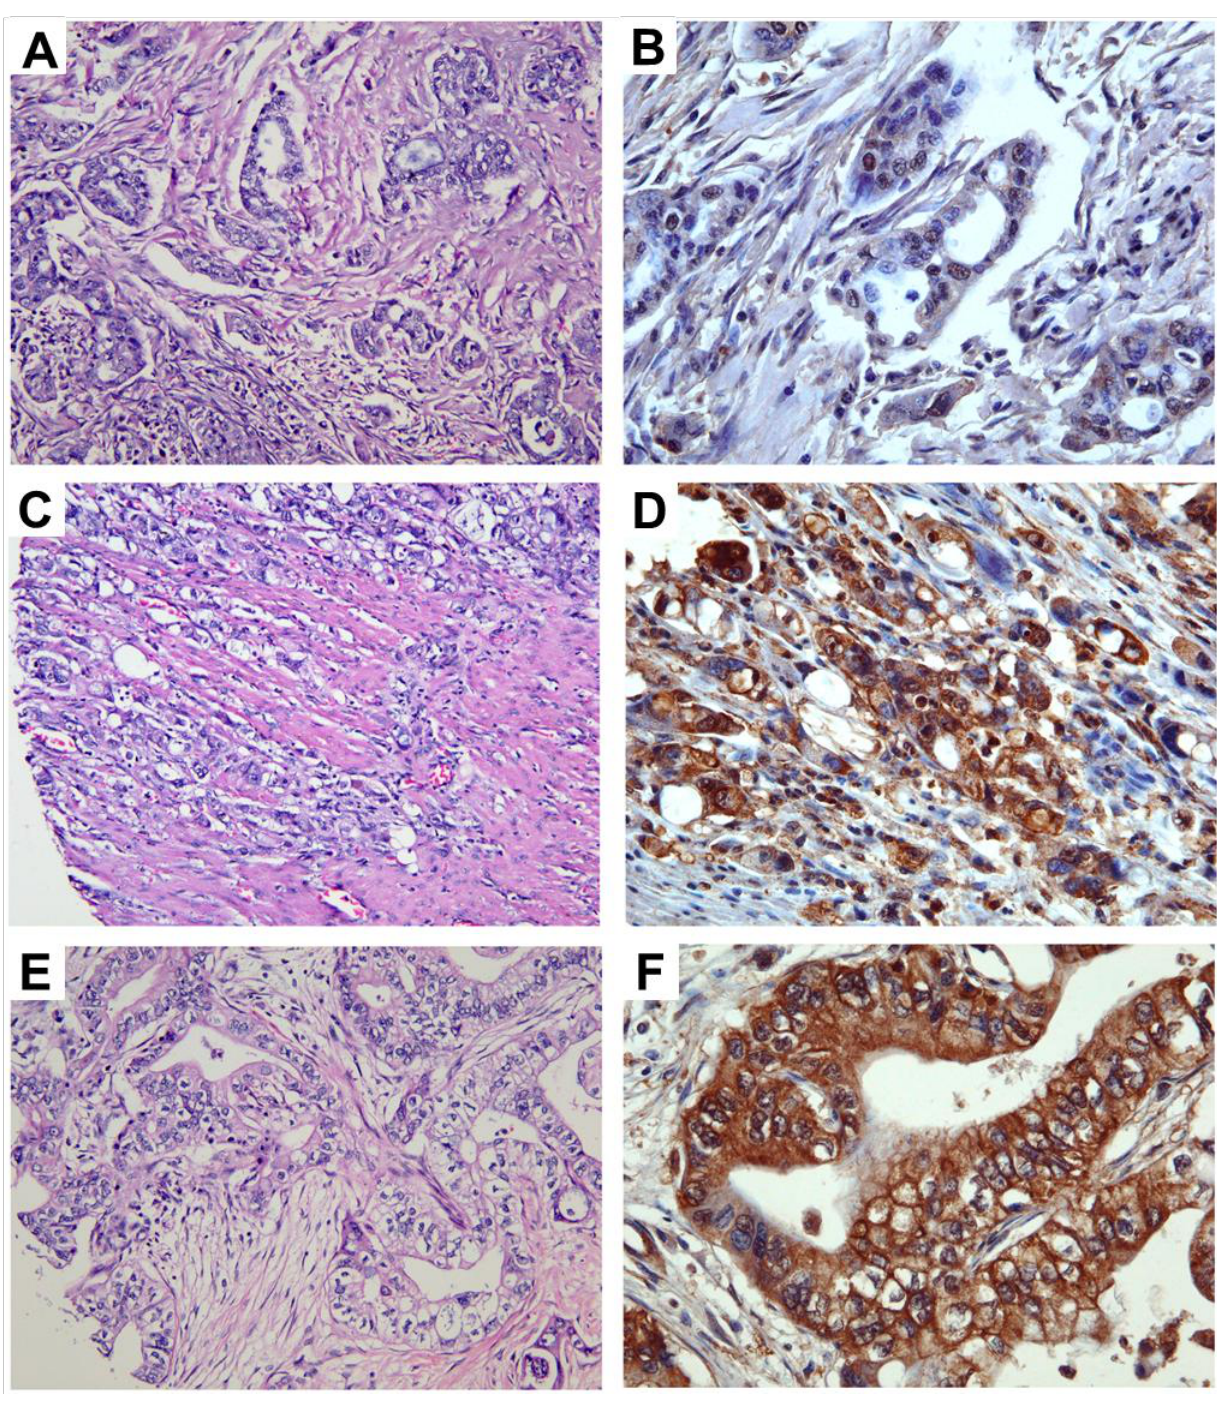
Figure 3. Expression levels of TRPM8 in pancreatic adenocarcinoma. Images in ( A , C , E ) (original magnification ×200) represent the H&E sections of the same tumor as the TRPM8 immunohistochemical staining in ( B , D , F) (original magnification ×400), respectively. Expression levels of TRPM8: ( B ) no-to-low; ( D ) moderate; ( F )